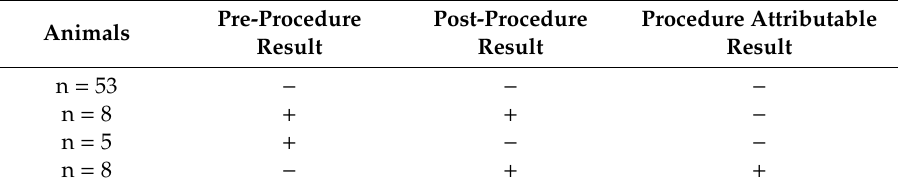
Table 1. Interpretation of the hemoculture results attributable to the